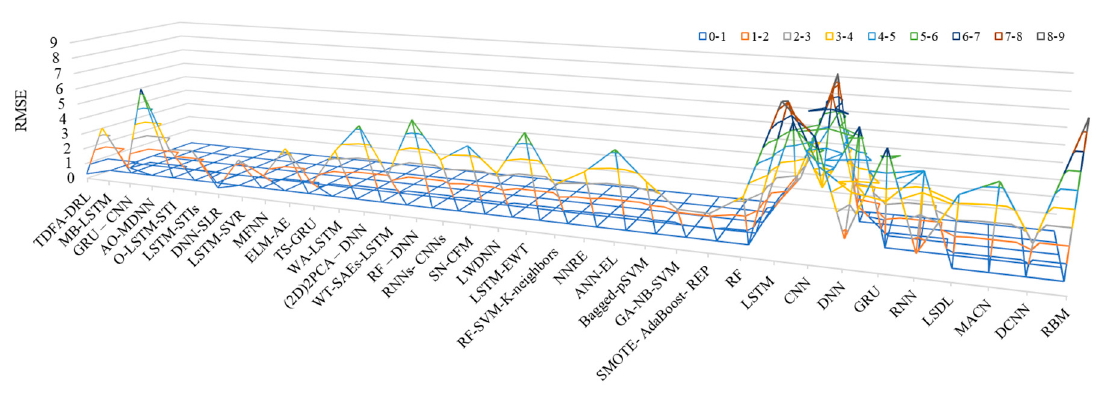
Figure8. Figure 8. Comparison of root-mean-squared error values of hybrid deep learning models and deep learning.